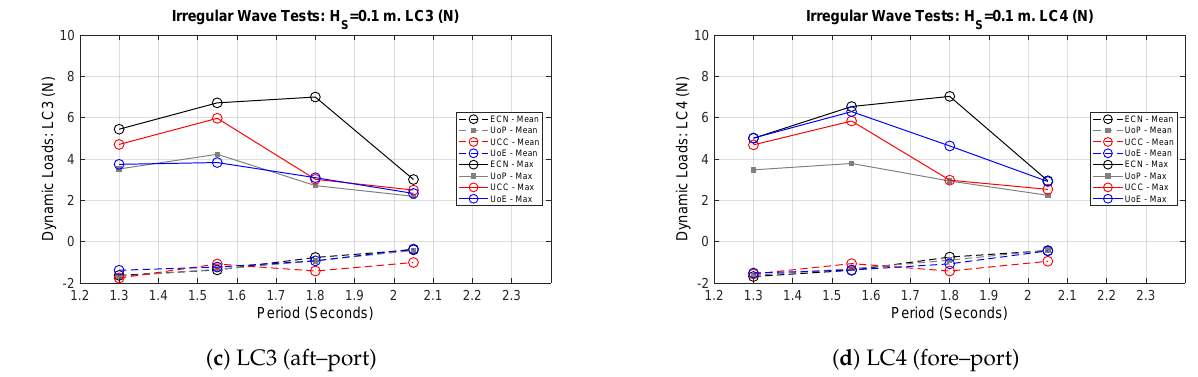
Figure 9. Load cell dynamic loads for H s of 0.1 m across